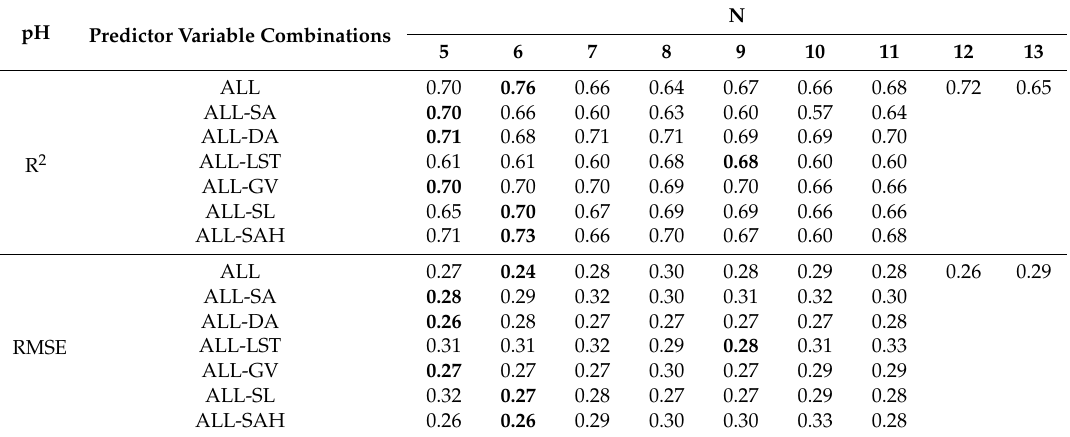
Table 5. ANN model performances of the different predictor variable combinations for soil pH